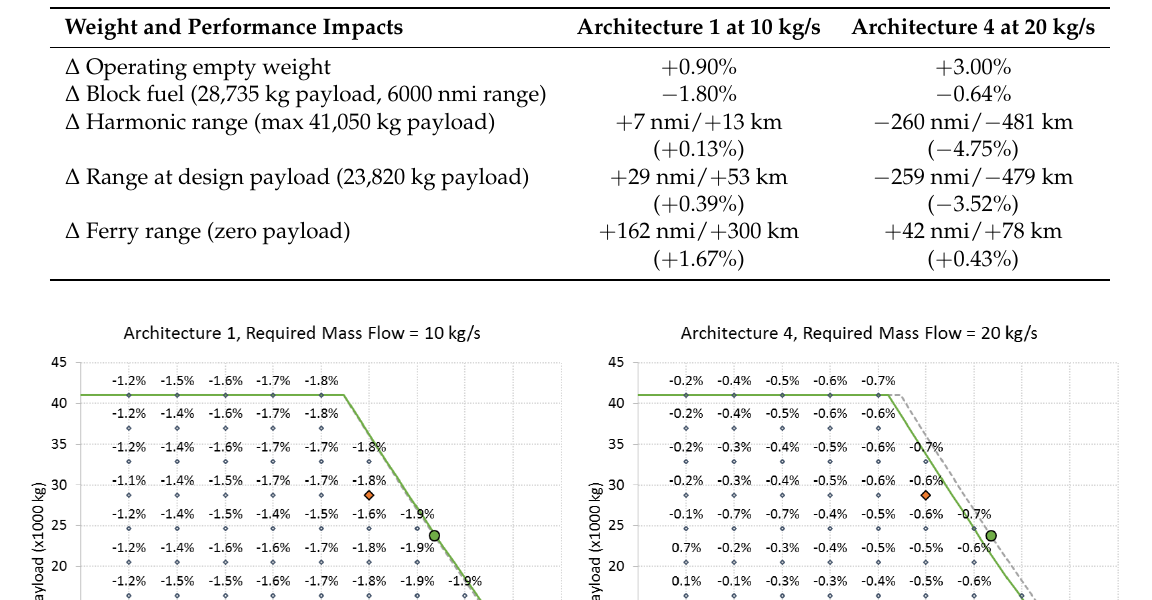
Table 4. Weight and performance impacts of the two architectures at different mass flow rates.